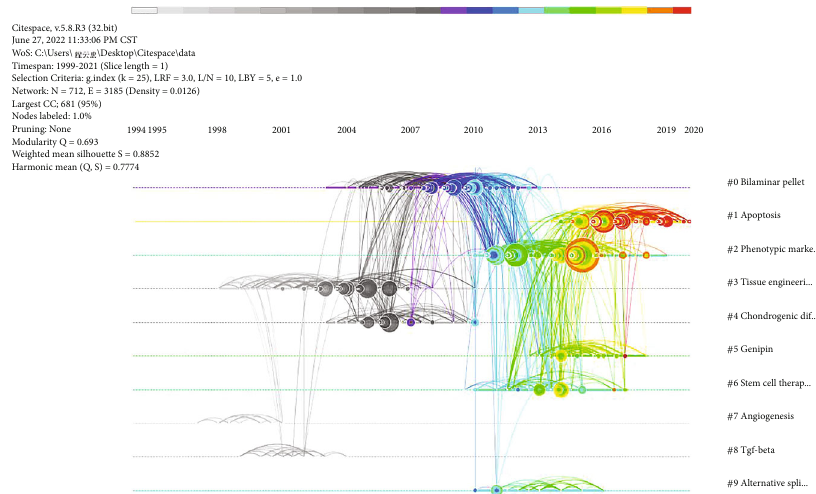
Figure 5: Co-citation timeline of references by keywords on stem and progenitor cells in intervertebral discs. (The nodes represent the references. The larger the node, the more citations the reference. The colors of the nodes from the inside to the outside correspond to color scale, which represents the total co-citations for the reference in the speci fi c year. The line between two nodes represents two references co-citations. The thicker the line, the more the co-citations. The color of the connection line corresponds to the color mark above, which can re fl ect the time when two references were fi rst